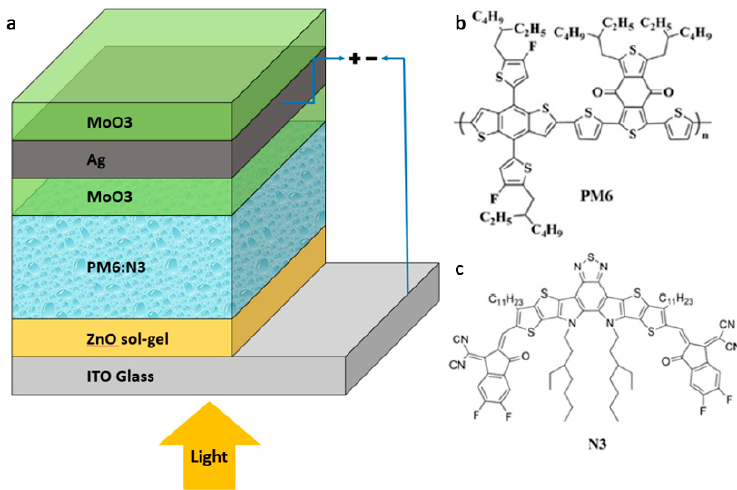
Figure 1. ( a ) The schematic diagram of the inverted device structure of indium tin oxide Figure1. ( a )Theschematicdiagramoftheinverteddevicestructureofindiumtinoxide(ITO) / ZnO / active (ITO)/ZnO/active layer/MoO 3 /Ag/MoO 3 for the fabricated semi-transparent devices; ( b ) the diagram layer / MoO 3 / Ag / MoO 3 forthefabricatedsemi-transparentdevices; ( b )thediagramofchemicalstructures of chemical structures of PM6; ( c ) the diagram of chemical structures of N3. of PM6; ( c ) the diagram of chemical structures of N3.